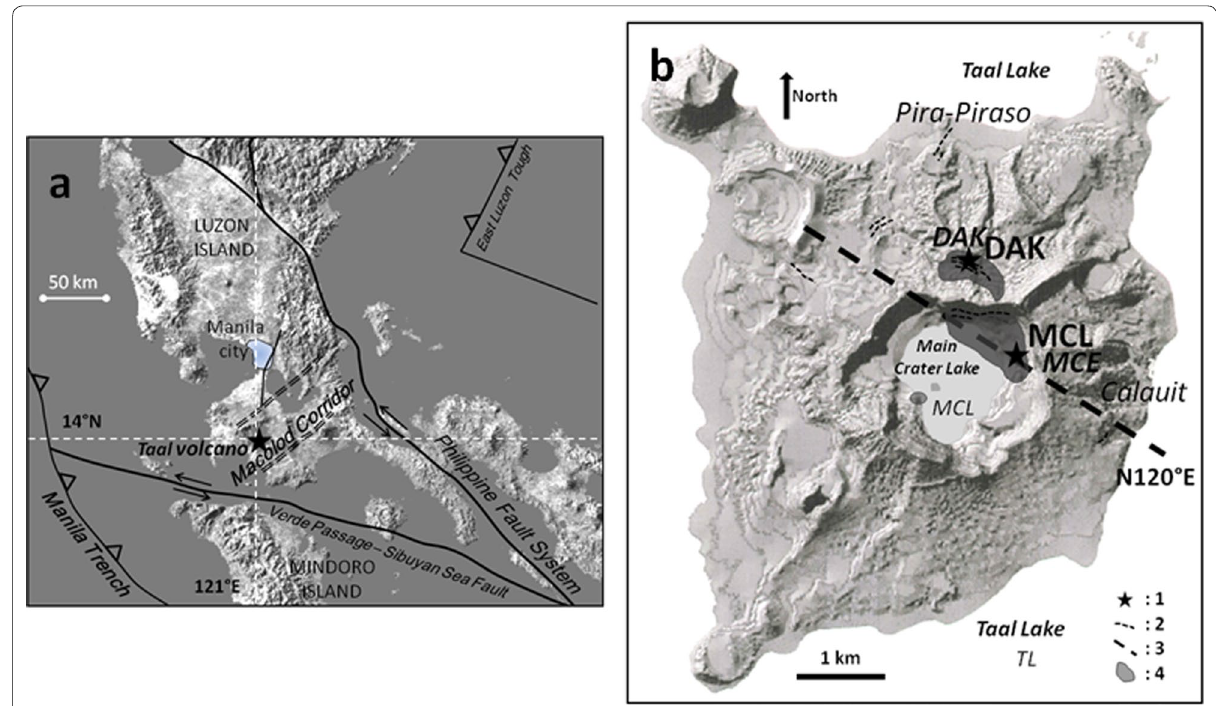
Fig. 1 a Schematic of the tectonics near Luzon Island in the Philippines archipelago. The location of Taal Volcano is marked by a black star. b Topographic map of the Volcano Island. 1 Stars show multi-parameters stations DAK and MCL; DAK and MCE are self-recording total field magnetometers; 2 Small dashed lines are fissures; 3 Dashed line shows the N120°E regional tectonic axis along which major hydrothermal activity takes place; 4 Dark gray areas show permanent geothermal fields defined by surface activity, higher heat flow and degassing